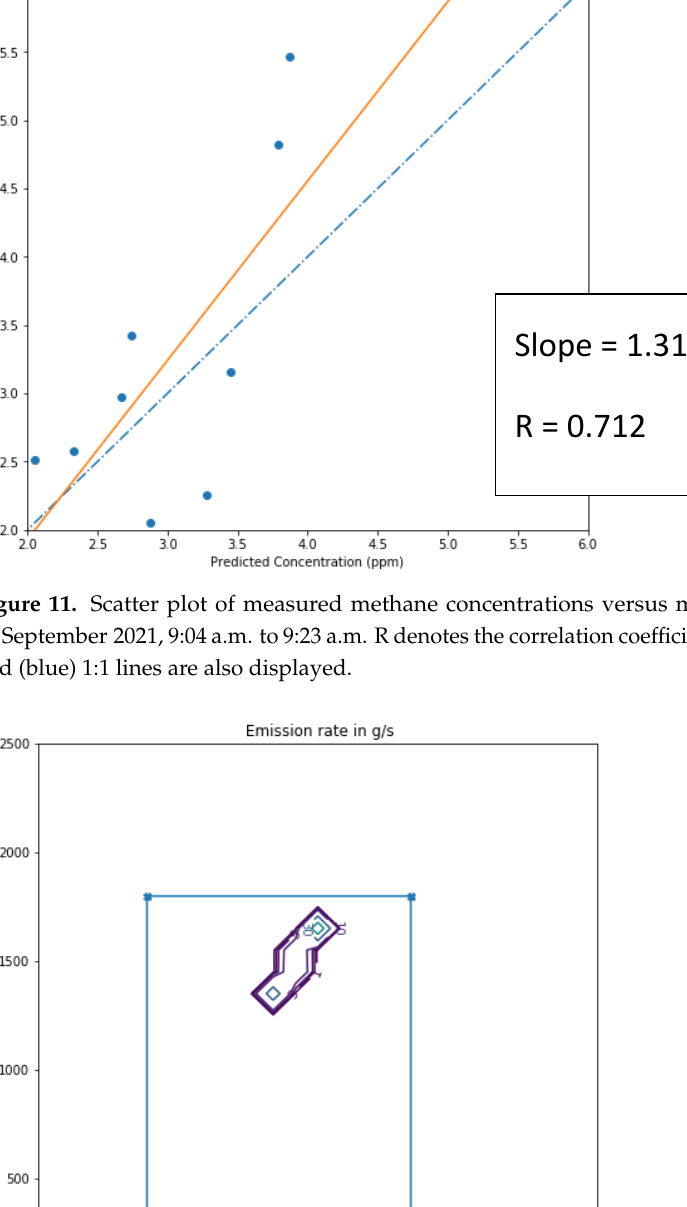
Figure 12. Inferred distribution of landfill emissions of methane on 14 September 2021, 9:04 a.m. to 9:23 a.m., based on drone measurements. Contours are drawn for 1, 3, 5, 10, 30, and 50 g/s. Blue line is approximate border of the landfill.